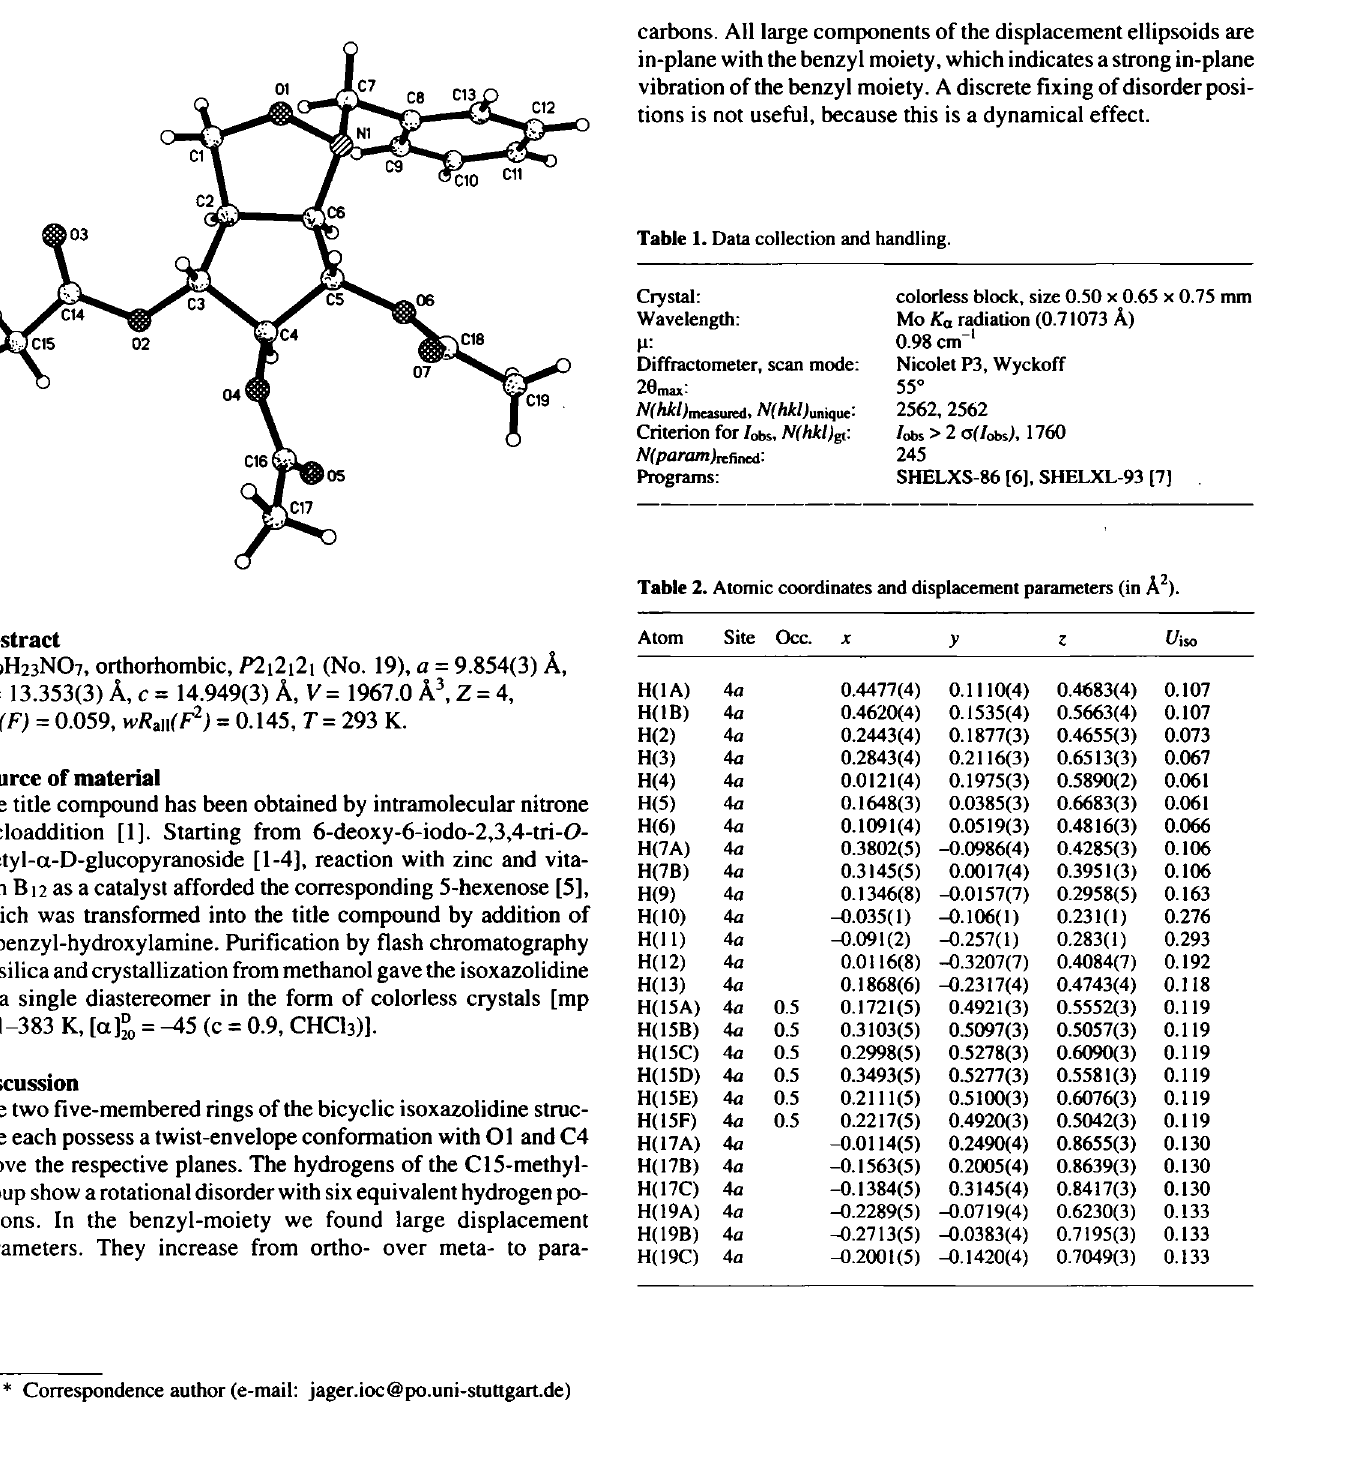
Table 1. Data collection and handling.